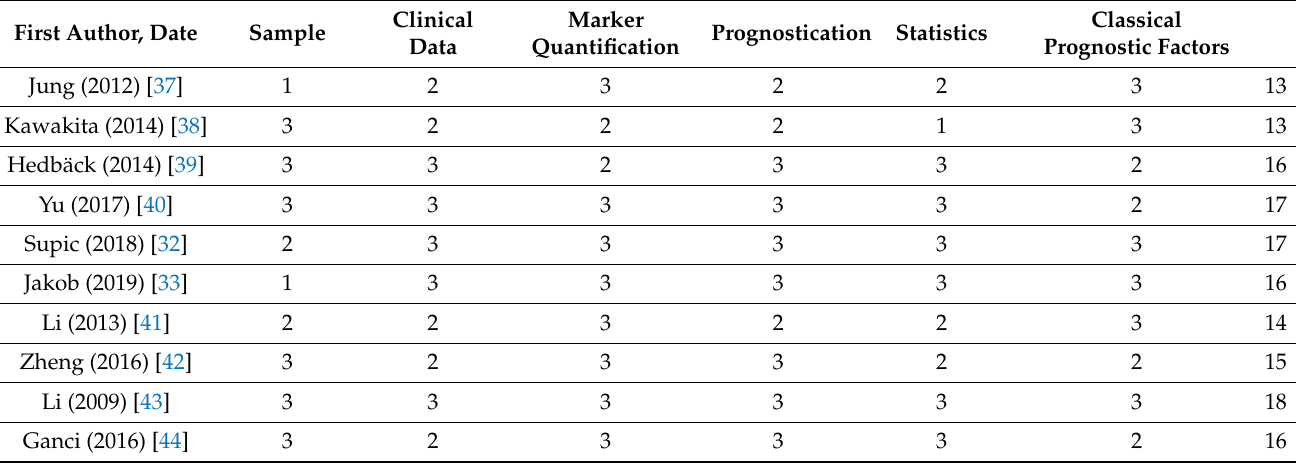
Table 2. Assessment of risk of bias within the studies.